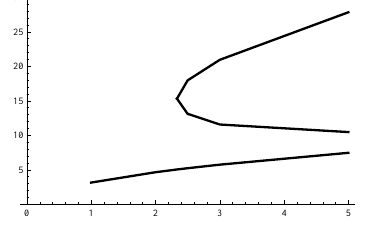
Figure 4. Solution curve, the lower branch in fact starts at the origin.